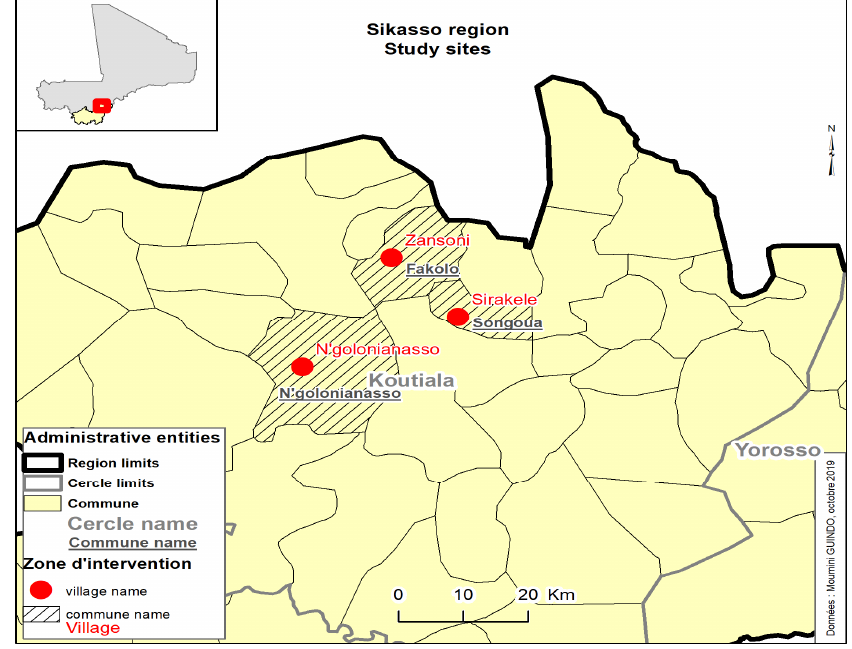
Figure 1. Study sites.